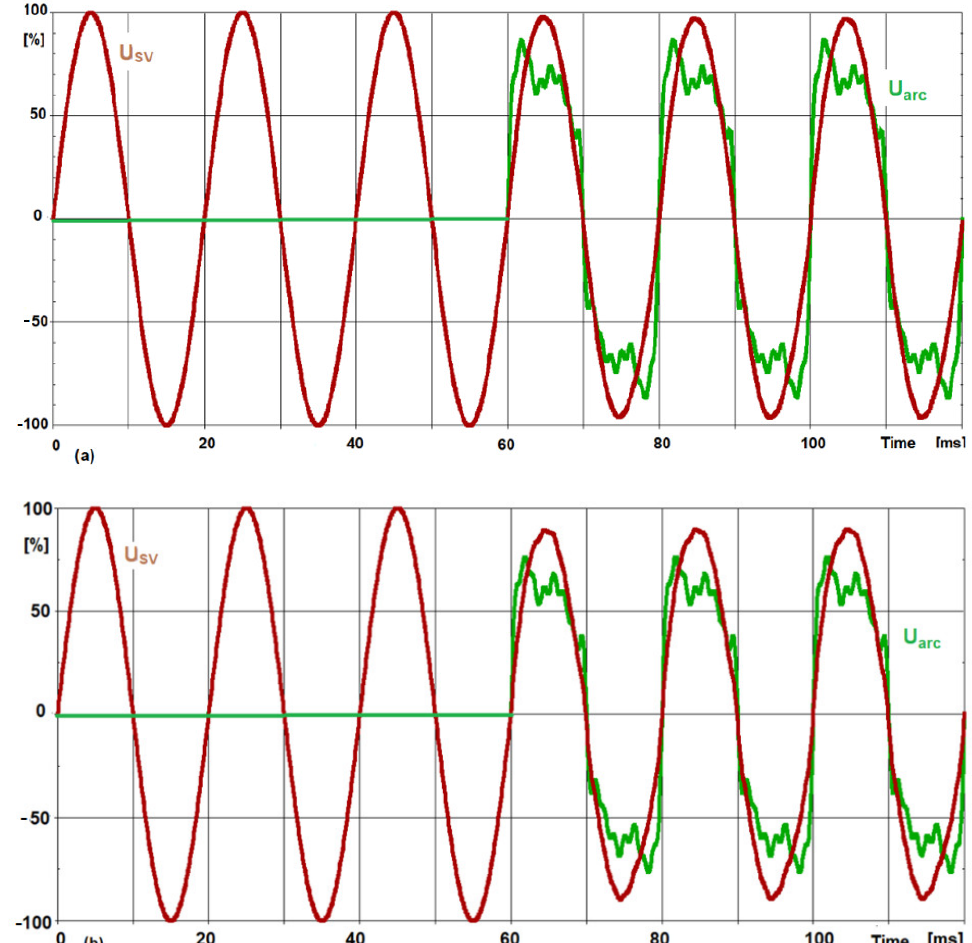
Figure 18. Oscillograms of the voltage in the supply line U SV ( t ) and the arc voltage U arc ( t ) for S cc / S ts = 134 ( a ) and S cc / S ts = 20 ( b ) [31].